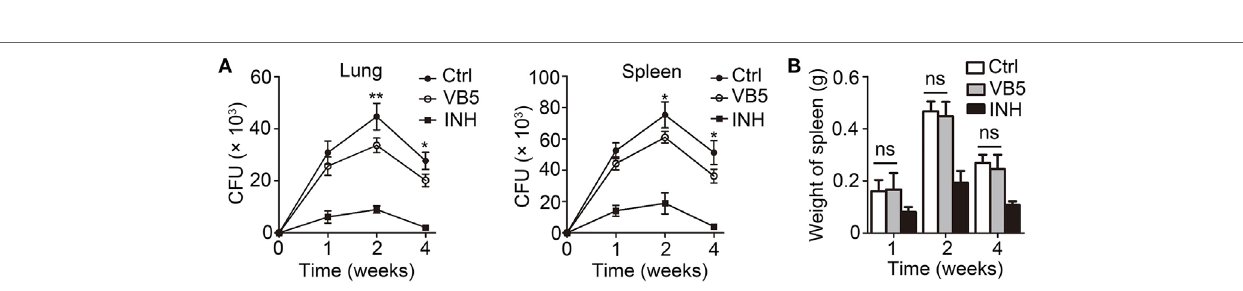
FigUre 4 | The anti-bacillus effect of vitamin B5 (VB5) in mice with Mycobacterium tuberculosis infection. C57BL/6J mice were infected with H37Rv (~200 bacteria/mouse). Oral administration with phosphate buffer solution, VB5, and INH was started from the day after infection (day 1) and continued for 1, 2, and 4 weeks alternatively. The lungs and spleens were analyzed at indicated time. (a) Colony-forming units (CFUs) were obtained from the lungs and spleen cell lysates by serial dilution and plating on 7H10 agar in triplicate. The colonies were counted after 4 weeks. (B) Spleen weights were detected. Data shown are the mean ± SD. * P < 0.05, *** P < 0.001. Data are representative of three independent experiments with similar